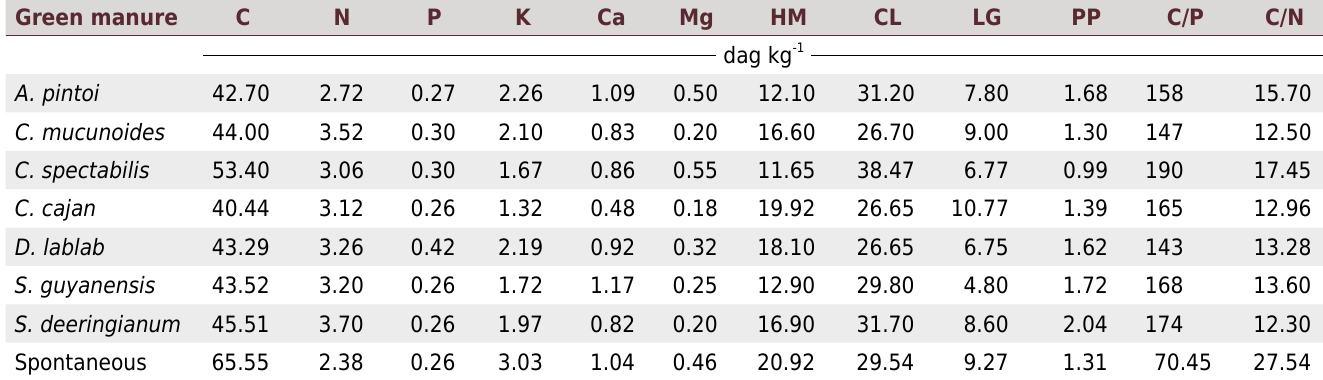
Table 2. Chemical and biochemical contents of the green manures and spontaneous plants on the four farms located in the Zona da Mata region, state of Minas Gerais, Brazil Green manure